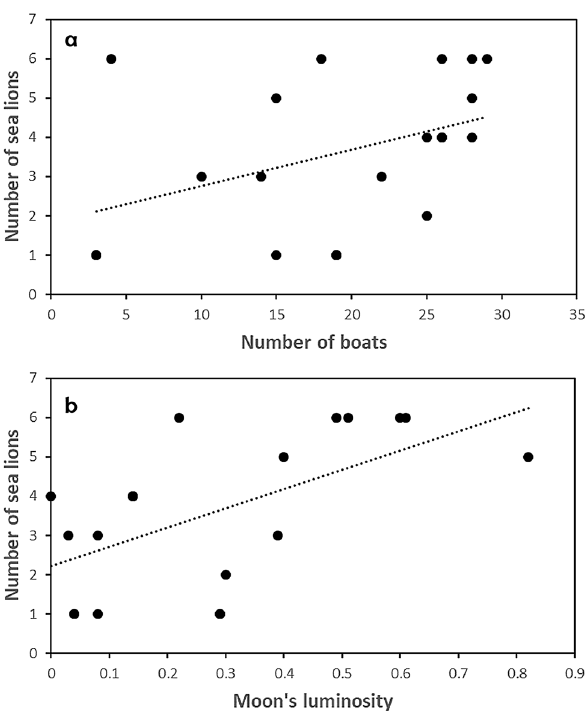
Figure 2. Relationship between ( a ) number of boats operating and number of SASLs, and ( b ) moon’s luminosity and number of